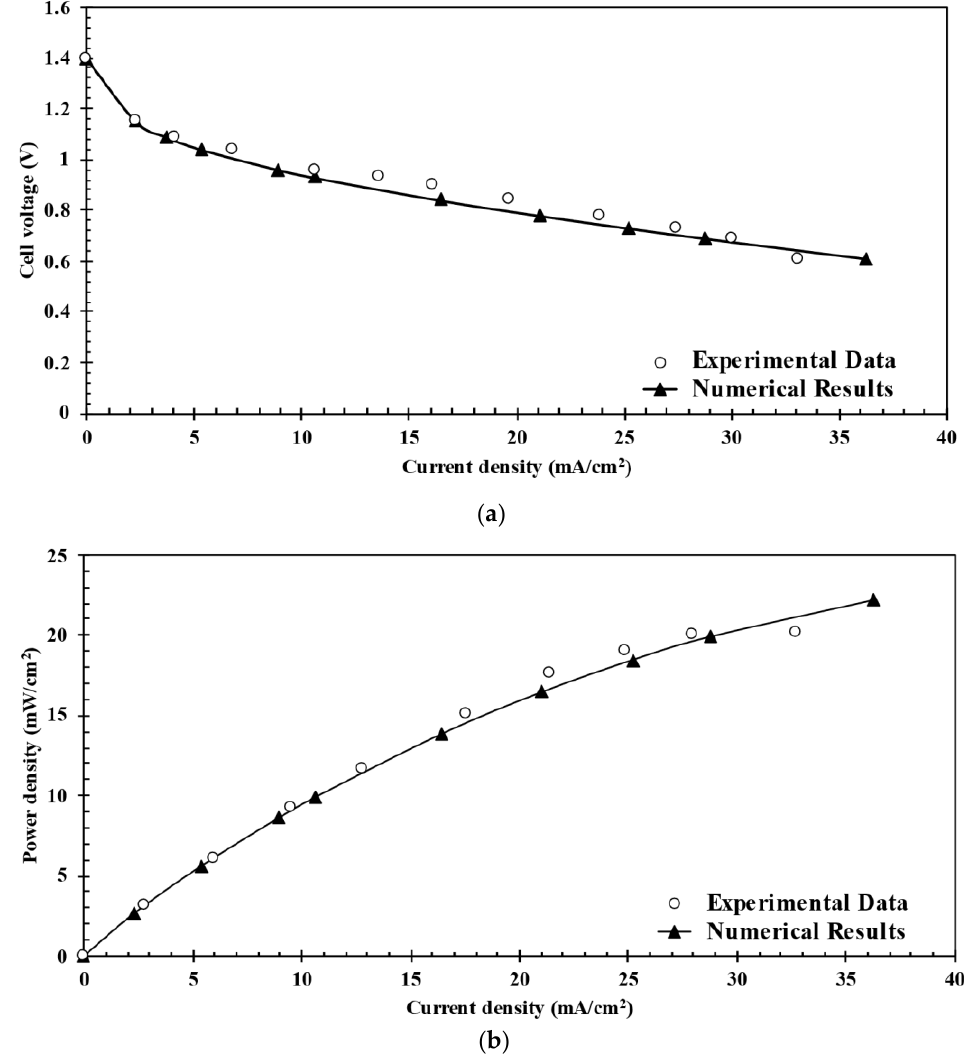
Figure 5. Validation of the predicted performance curves [30] using experimental data of Montesinos et al. [17]. ( a ) Cell voltage; ( b ) power density.